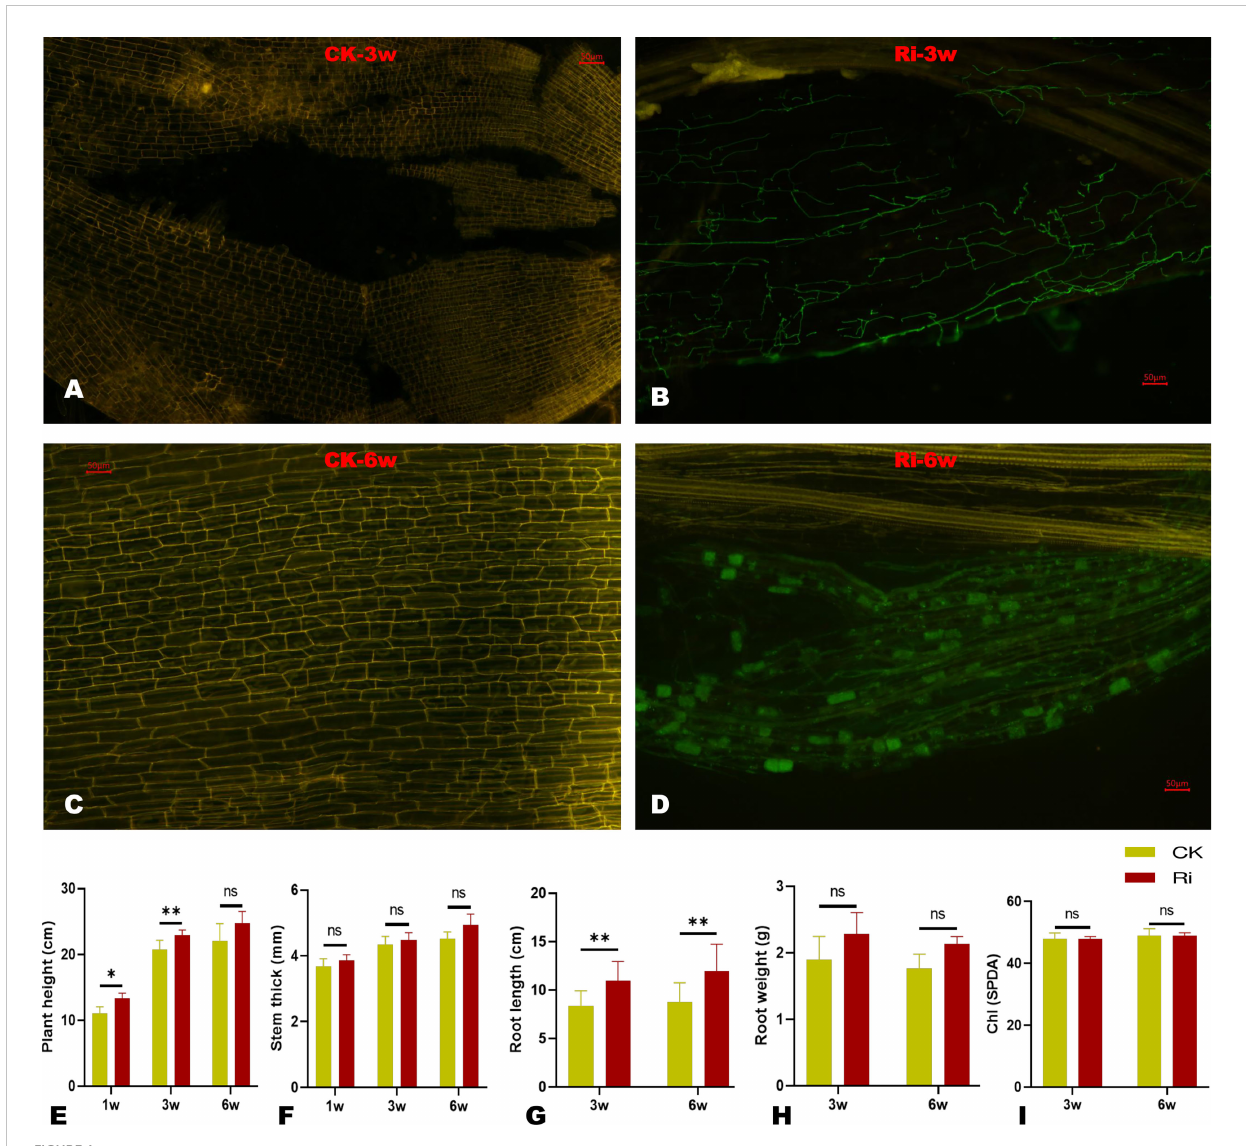
FIGURE 1 Microscopic observation and impacts of AM symbiosis on some physiological traits after three (3w) and six (6w) weeks of AMF inoculation. (A, B) Microscopic image of symbiotic cells at 3w of control (CK) and inoculated plants (Ri), respectively. (C, D) Microscopic images of symbiotic cells at 6w of control (CK) and inoculated plants (Ri), respectively. The green organelles in D and F indicate proliferating fungal hyphae. Pictures were taken at 10x, and scale bars indicate 50 µm. (E – J) Evaluation of some physiological traits, including plant height, stem thickness, root length, root dry weight, and leaf chlorophyll content, respectively. The data are presented as mean ± SD of three replicates. Comparisons were evaluated between CK and Ri at each time point using t-test at P < 0.05. * and ** indicate signi fi cant differences at P < 0.05 and P < 0.01, respectively. “ ns ” indicate not signi fi cantly